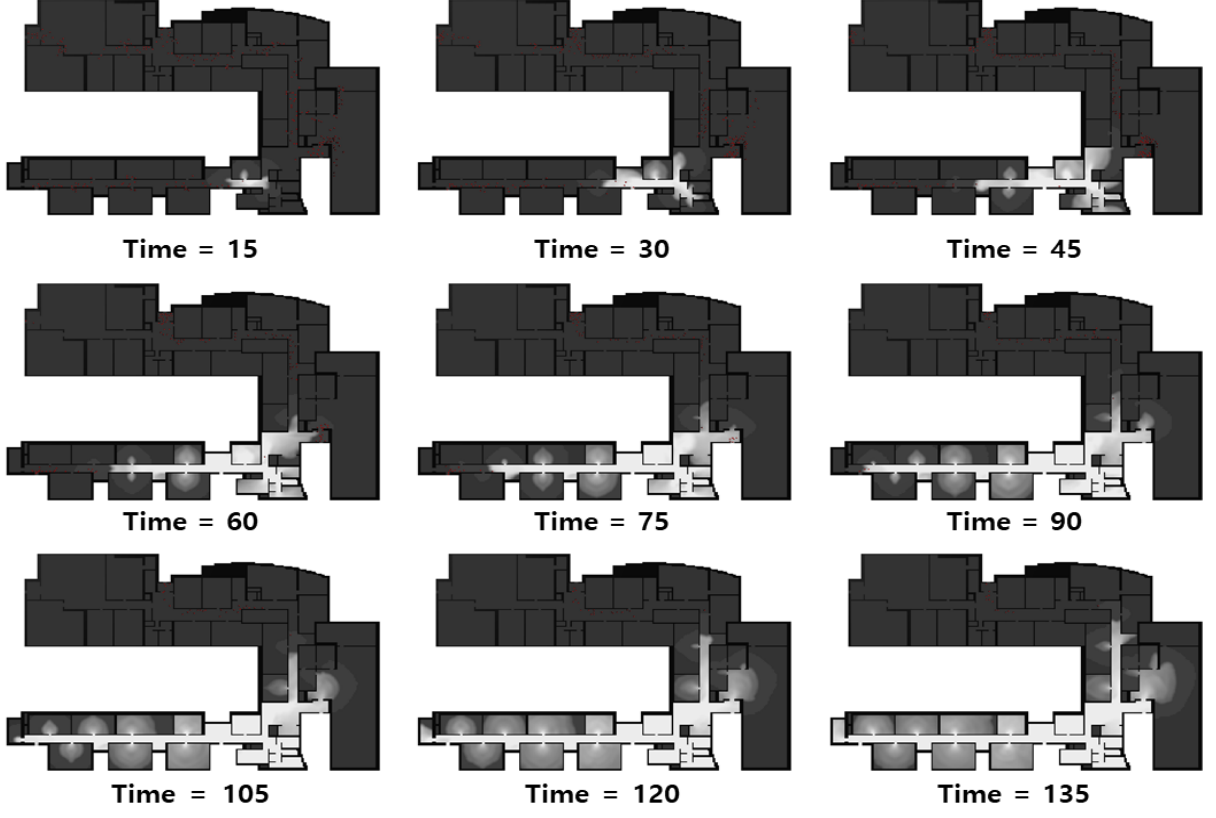
Figure 12. The simulation on situation 3